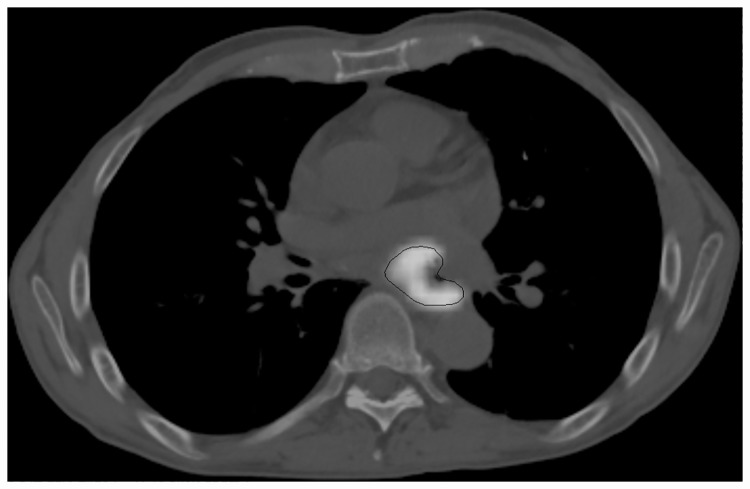
PET/CT slice of the chest with a segmented esophageal tumor.